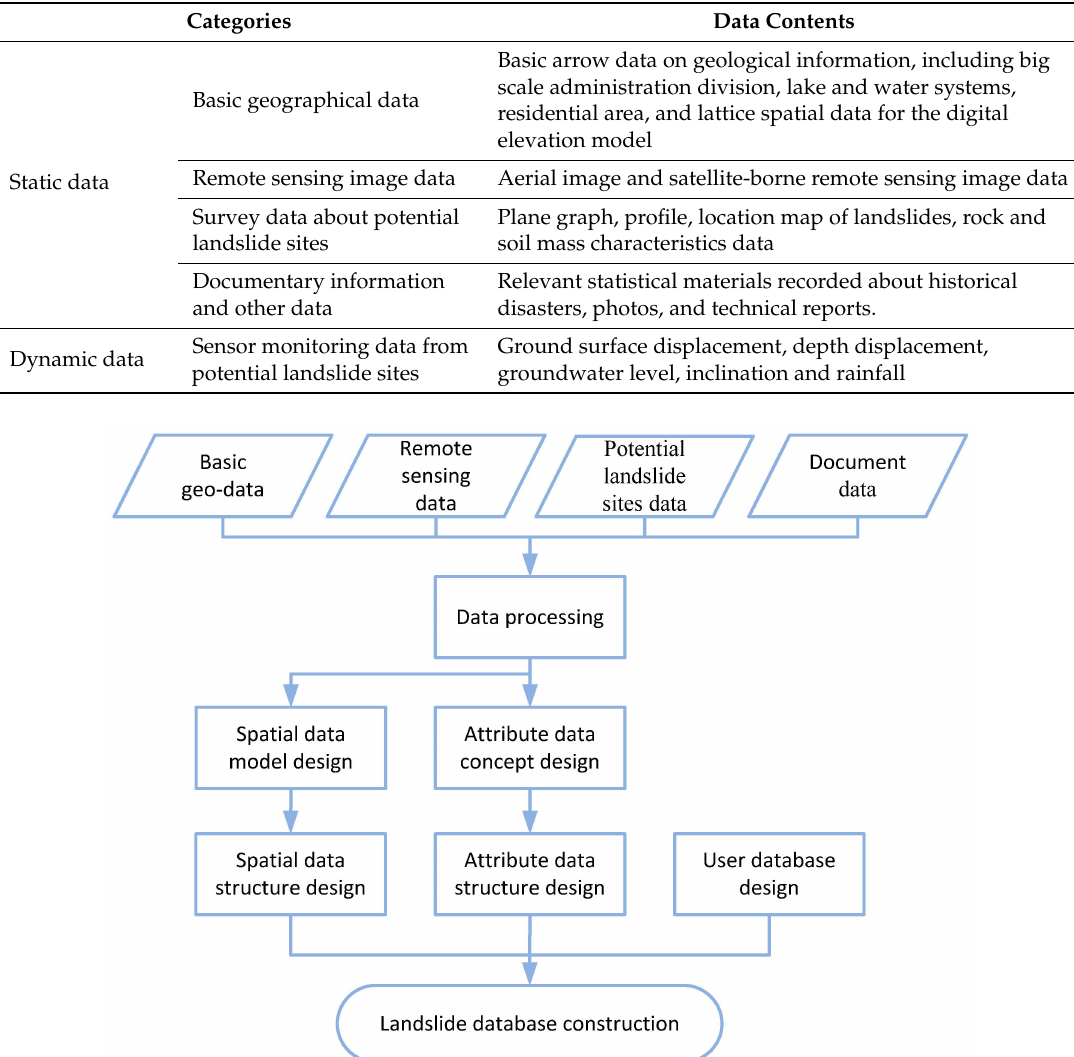
Table 1. Landslide Monitoring Data Categories.